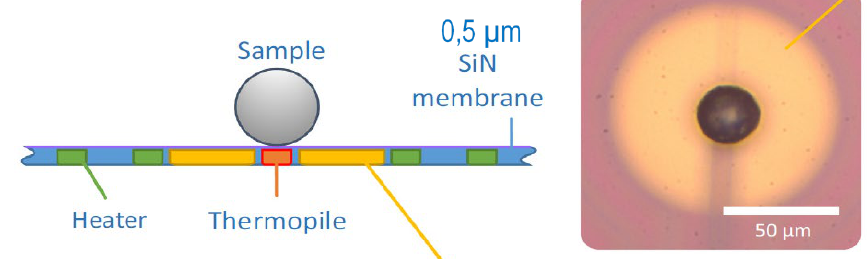
Figure 1. Schematic of the DFSC sensor (side view) as well as a light micrograph (top view) [5].